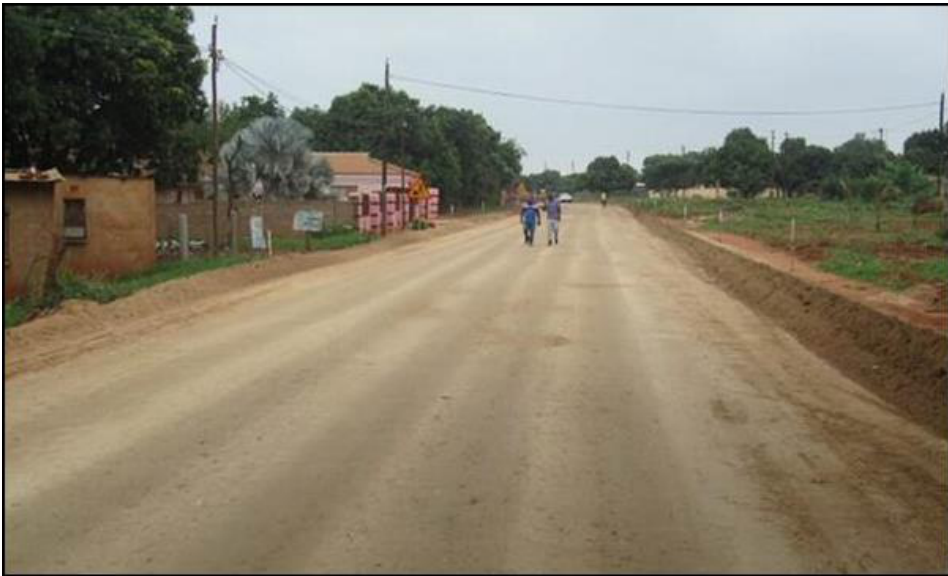
Figure 12. Recycled road with NME stabilisation opened to local traffic to provide access to houses, with no protective prime or surfacing added (note the same, pink-painted façade of the same house shown in Figure 11a).